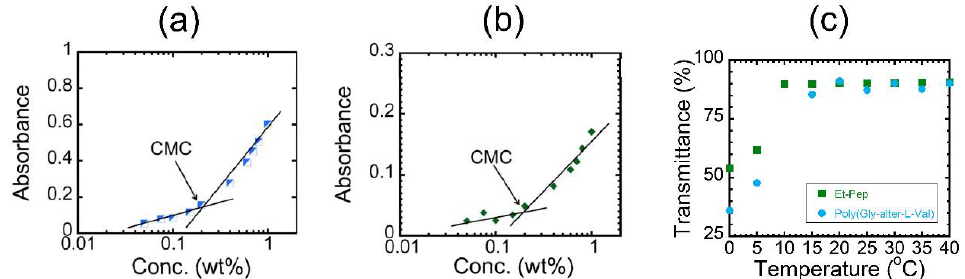
Figure 2. The absorbance of ( a ) poly(Gly- alter - L -Val) and ( b ) Et-Pep as a function of concentration (wt%) at 25 ° C and ( c ) the temperature-dependence of transmittance of poly(Gly- alter - L -Val) (blue circle) and Et-Pep (green square) at 450 nm (1.5 wt%).